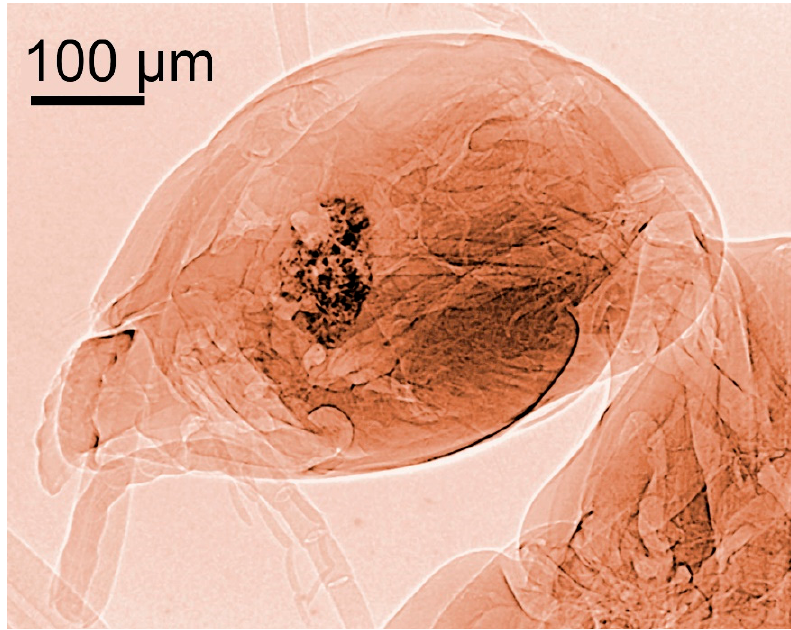
Figure 4. Coherence-based radiograph of the head of a housefly [13].